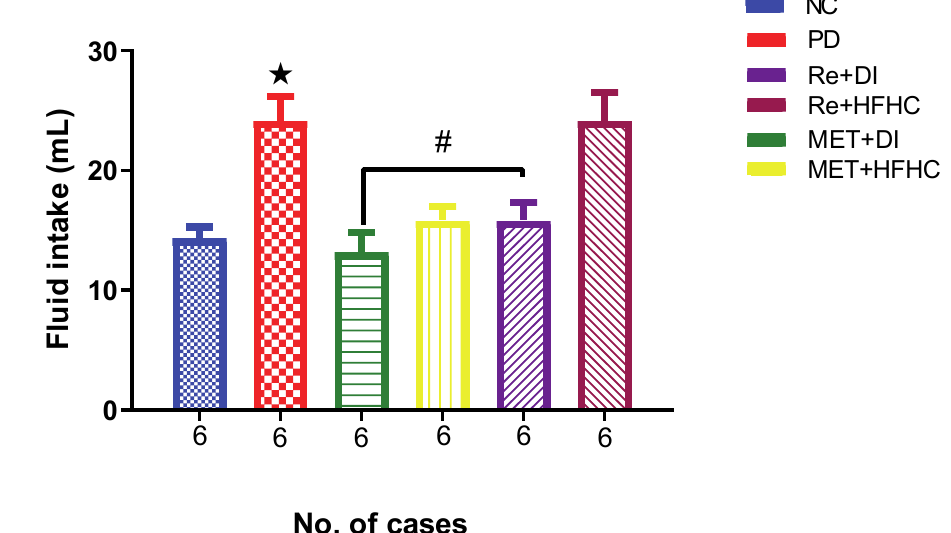
Figure 10. Fluid intake volume in normal control (NC), prediabetic control (PD), metformin and diet intervention (MET + DI), metformin and high-fat/high-carbohydrate diet (MET + HFHC), rhenium (V) compound and diet intervention (Re + DI) and rhenium (V) compound and high-fat/high-car- bohydrate diet (Re + HFHC) groups after 12 weeks of treatment. Values are presented as means ± SEM (n = 6).